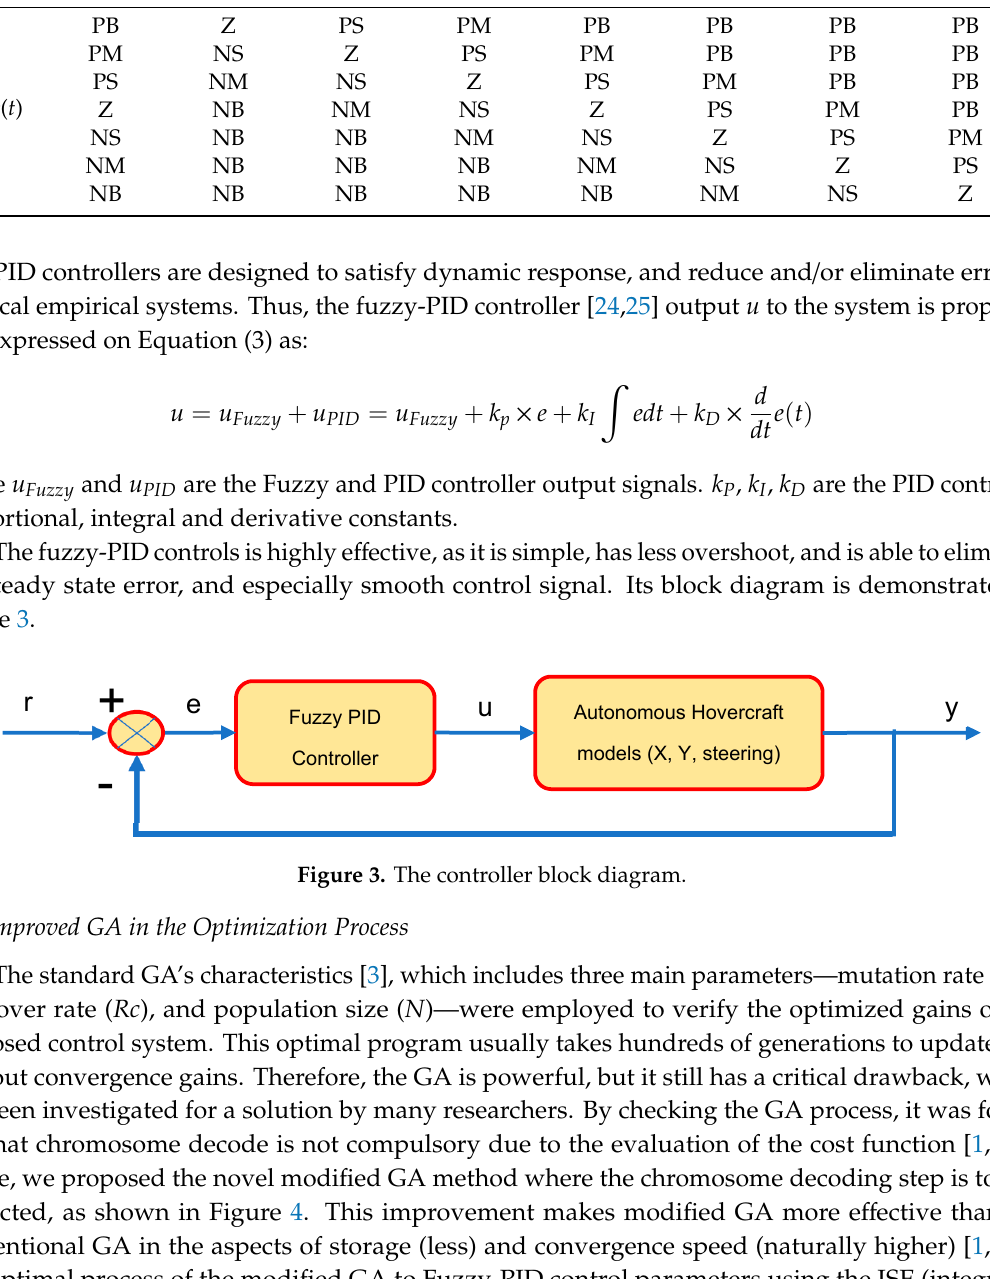
(cid:82) ∞ e 2 ( t ) dt 0